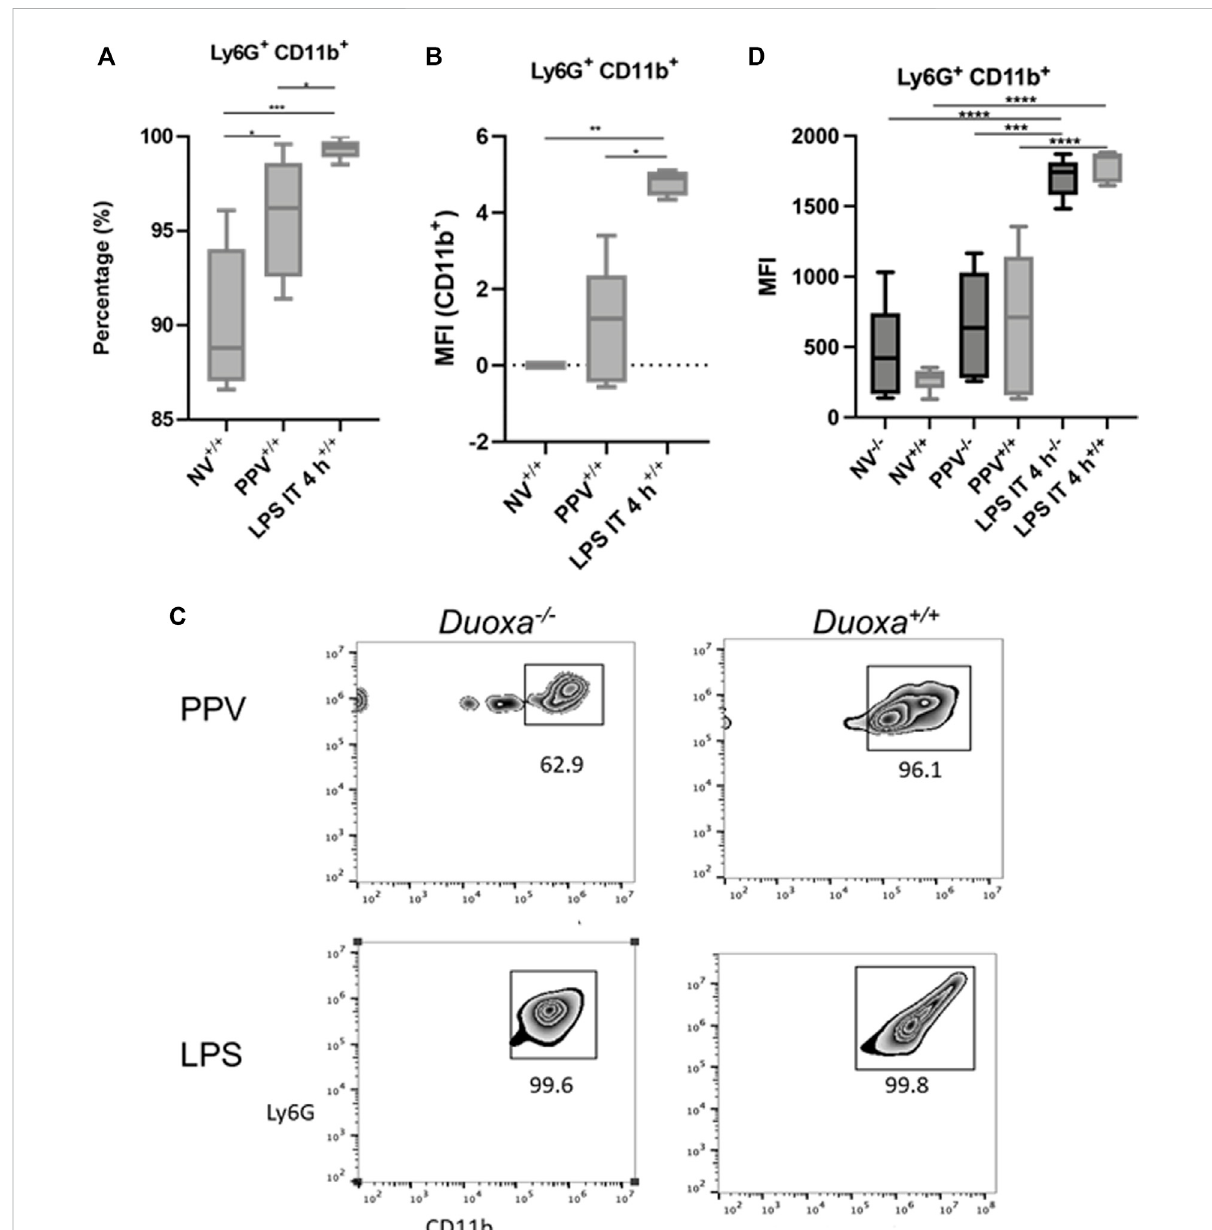
FIGURE 3 CD18activation mechanismsareDuox-independent. Duoxaknockoutmice( − / − )andwild-typemice(+/+)weresubjectedtoinjuriouspositive pressure ventilation (PPV) or instilled intratracheally with lipopolysaccharide (LPS) followed by isolation of neutrophils from bronchoalveolar lavage (BAL) by fl ow cytometry using Ly6G antibody and subsequently phenotyped using CD18/CD11b antibodies. (A) Percentage of CD11b + neutrophils isolated from BAL fl uid in wild-type mice with no exposure (NV), injurious positive pressure ventilation (PPV), or intratracheal LPS (LPS IT) (*, p = .029; **, p = .0009). (B) Mean fl uorescence intensity (MFI) of Ly6G + , CD18/CD11b + neutrophils in PPV- or LPS-exposed mice compared to non- ventilated, untreated controls (*, p = .025, **, p = .003). (C) Populations of Ly6G + ( y -axis), CD11b + ( x -axis) neutrophils in Duoxa knockout ( − / − ) compared to wild-type (+/+) mice after exposure to PPV or LPS. (D) MFI of BAL neutrophils gated for Ly6G + and CD18/CD11b + by fl ow cytometry isolated from wild-type (+/+) and Duoxa knockout ( − / − ) mice in non-ventilated, untreated (NV) controls compared to PPV- and LPS-exposed mice. (***, p = .002; ****, p <